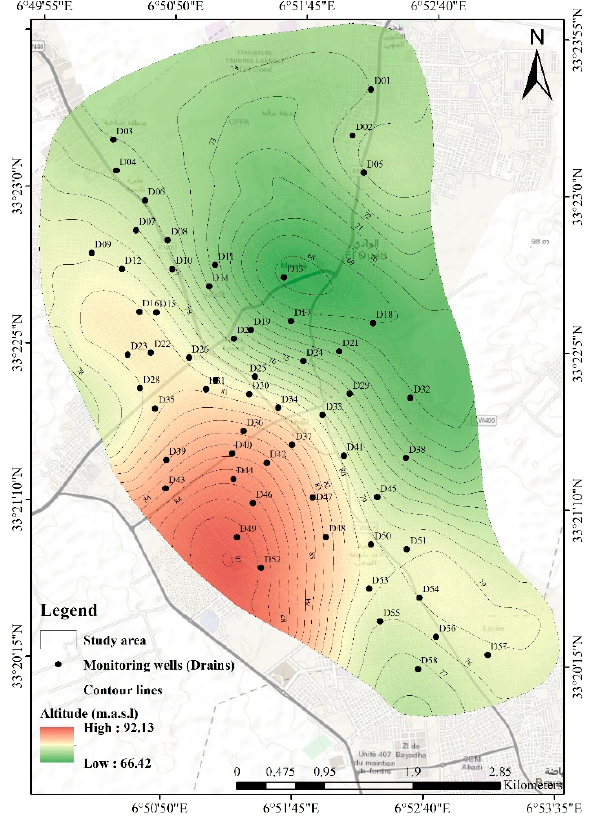
Figure 2. Topographic map of the study area.